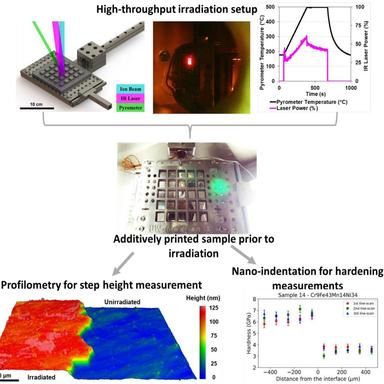
Schematic describing the high-throughput approach to heavy ion irradiation of CCA arrays: (upper left) schematic of the automated stage and CCA arrays position relative to the triple beam, (upper middle) picture of a CCA under the laser beam at high-temperature, (upper right) IR laser power and sample surface temperature as function of time and (middle) picture of the CCA arrays with the insertion of the Mo mask. Typical automated post-characterization results are shown with step-height (bottom left) and ha